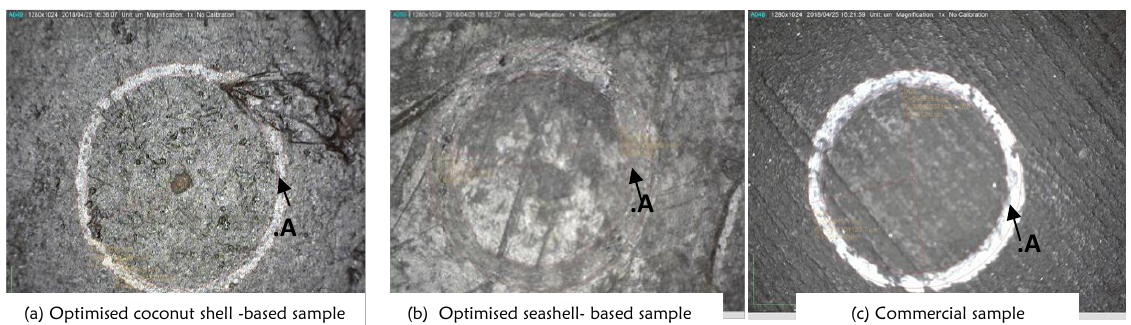
Figure 4: Morphology of wear track section on tribometer